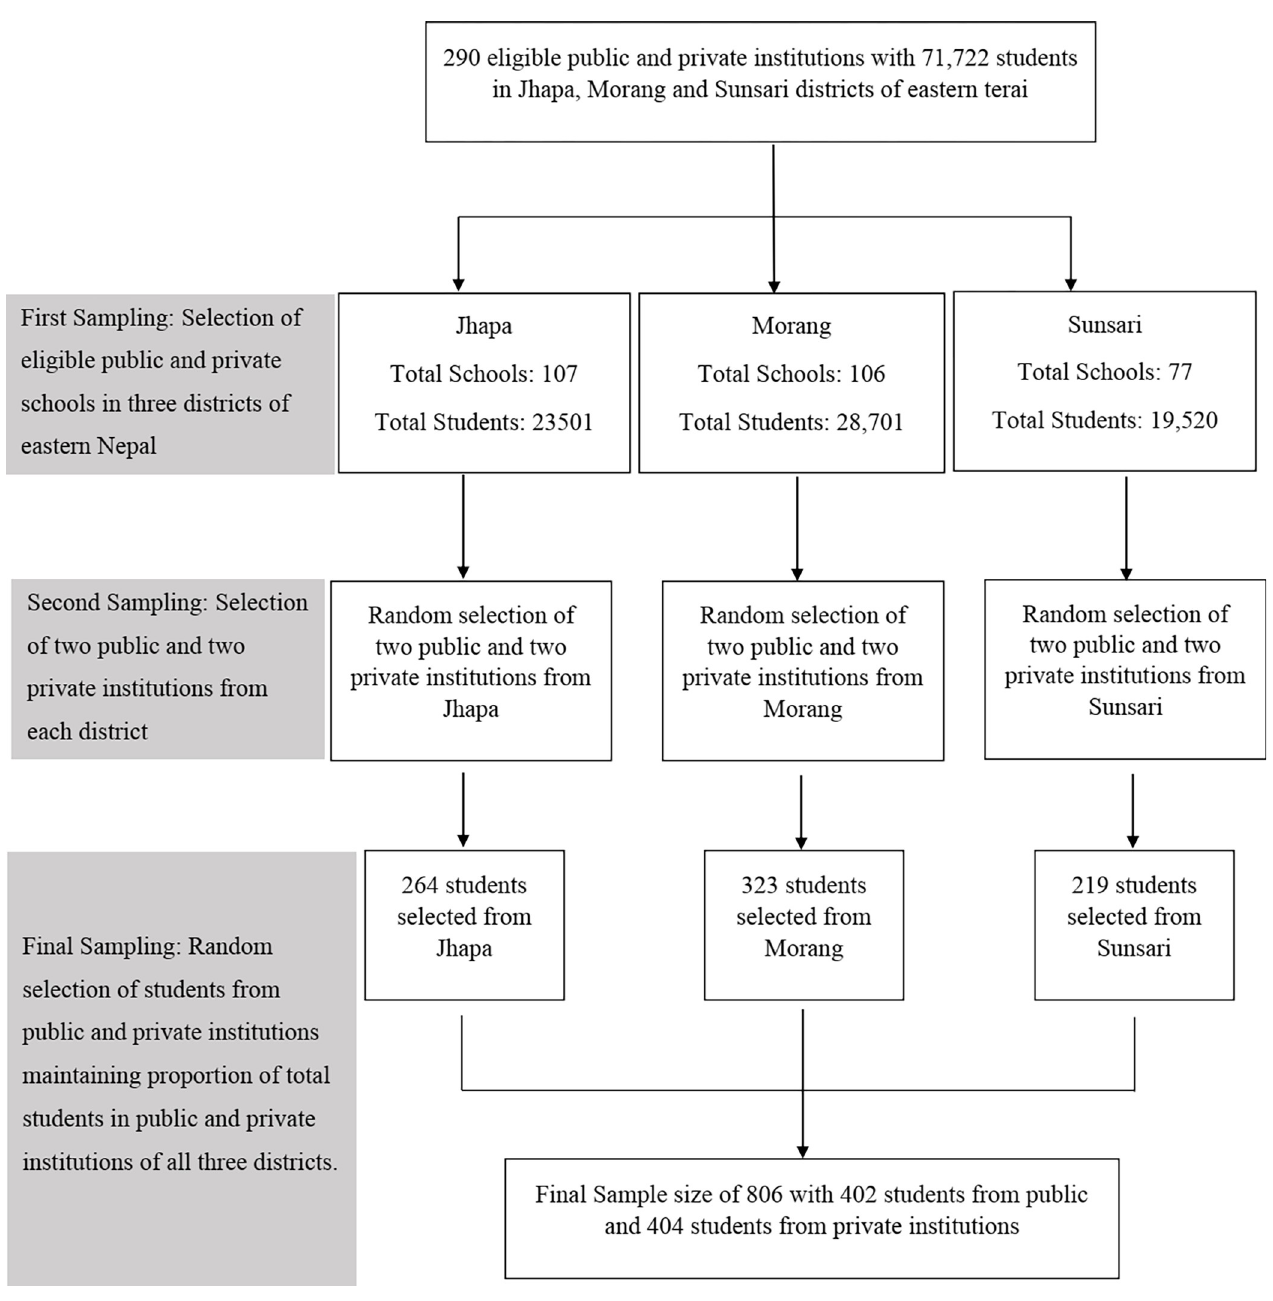
Fig 1. Flowchart depicting the process of multistage stratified proportionate random